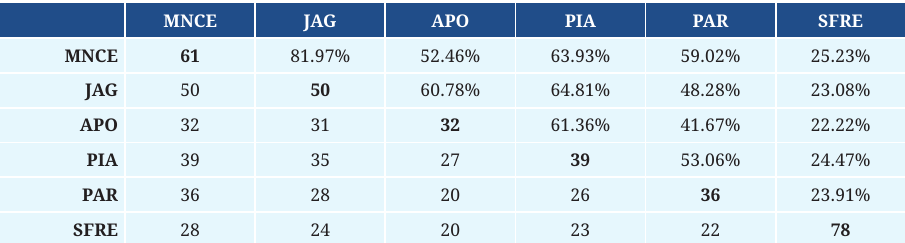
TABLE 2 | Number and percentage of shared native fish species in the São Francisco Interbasin Water Transfer Project basins in the Brazilian semiarid. Number of species in each basin and ecoregion on the diagonal in bold. SFRE = São Francisco Ecoregion (lower-middle São Francisco basin); MNCE = Mid- Northeastern Caatinga Ecoregion (JAG+APO+PIA+PAR); JAG = Jaguaribe basin; APO = Apodi-Mossoró basin; PIA = Piranhas-Açu basin; PAR = Paraíba do Norte